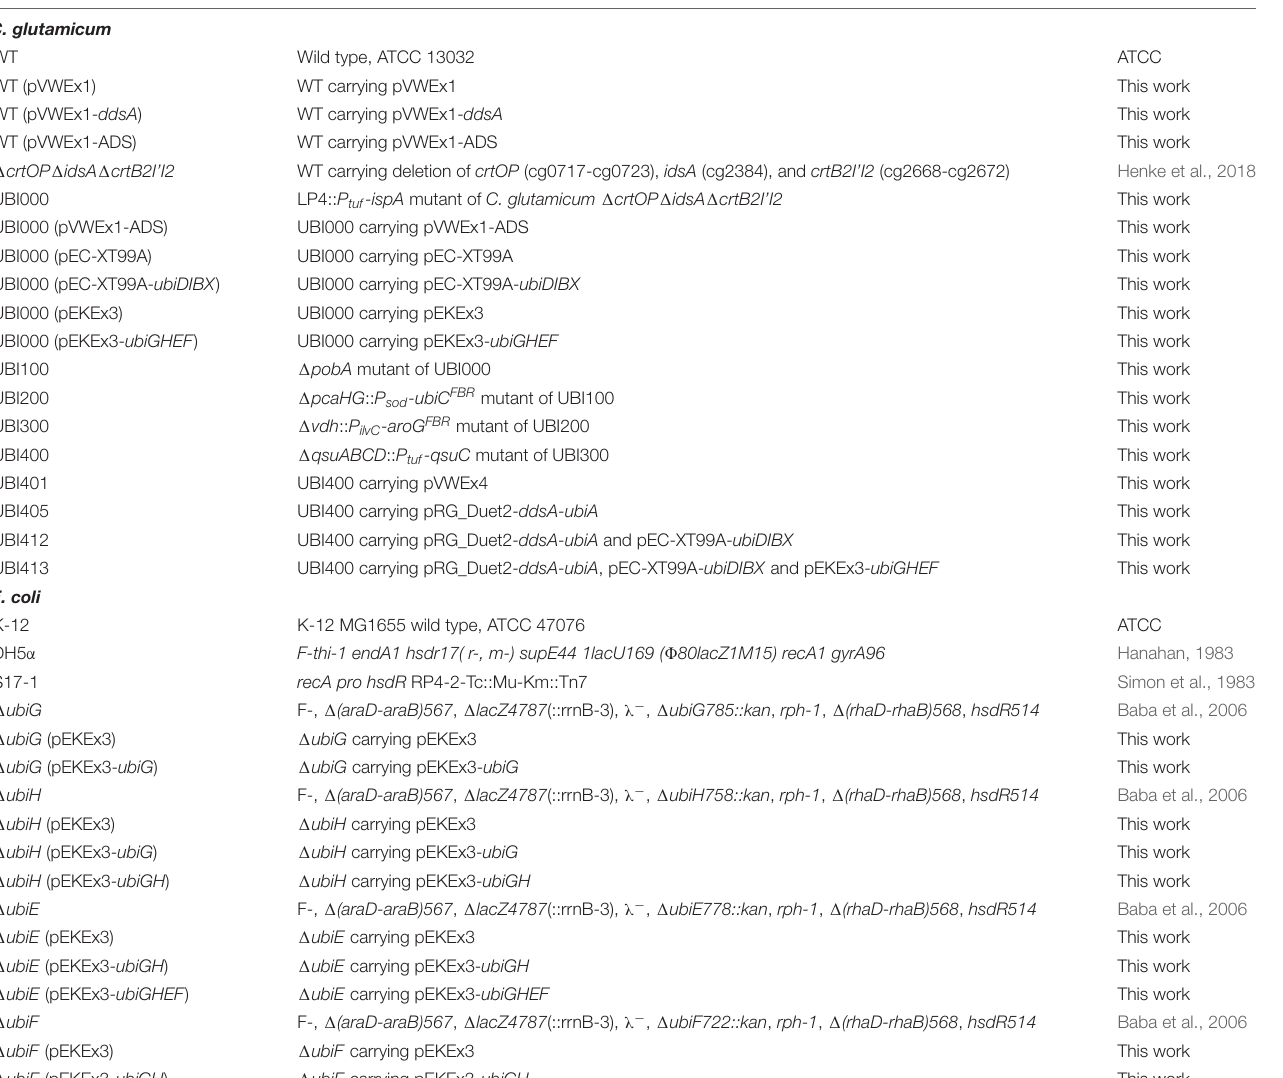
TABLE 1 | Strains used in this